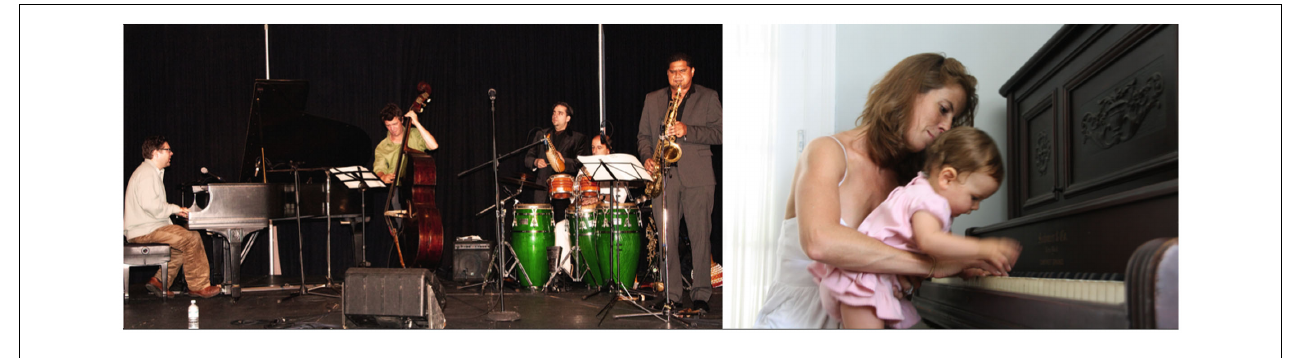
can be seen in early forms of joint action between an infant and caretaker, and might provide a foundation for the development of musical